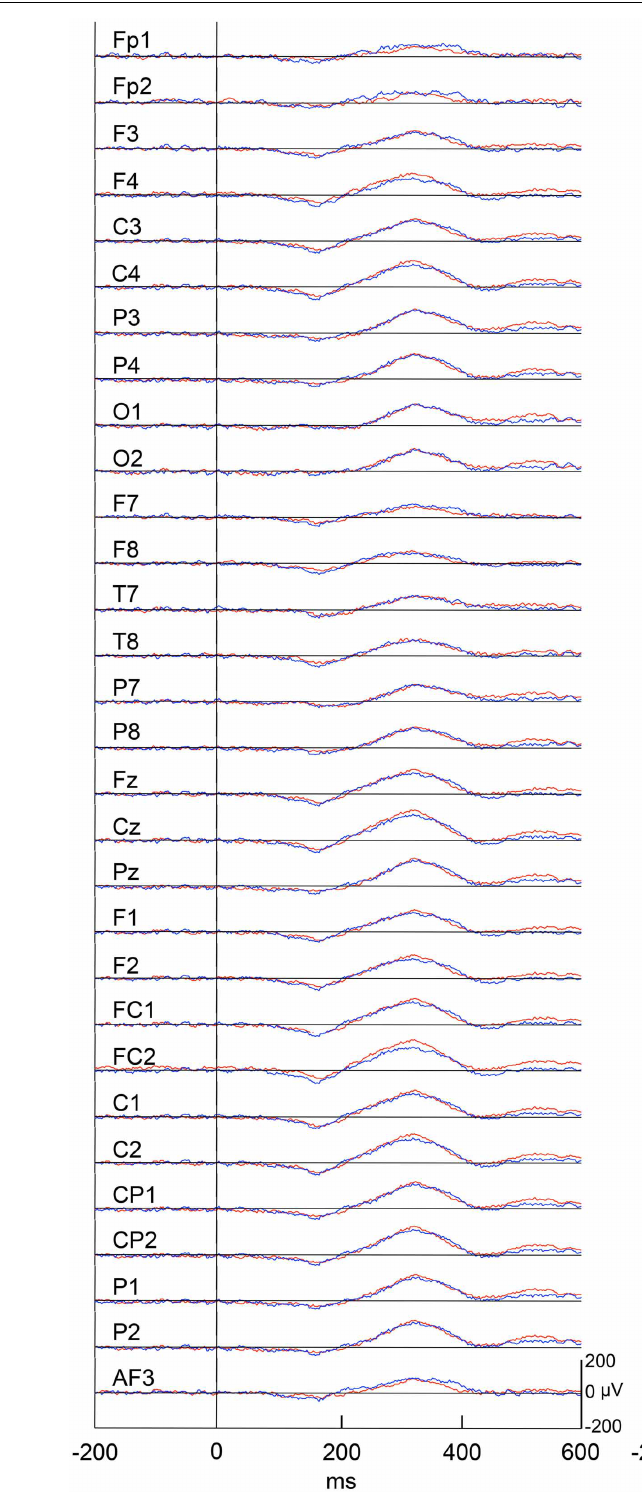
Frontiers in Behavioral